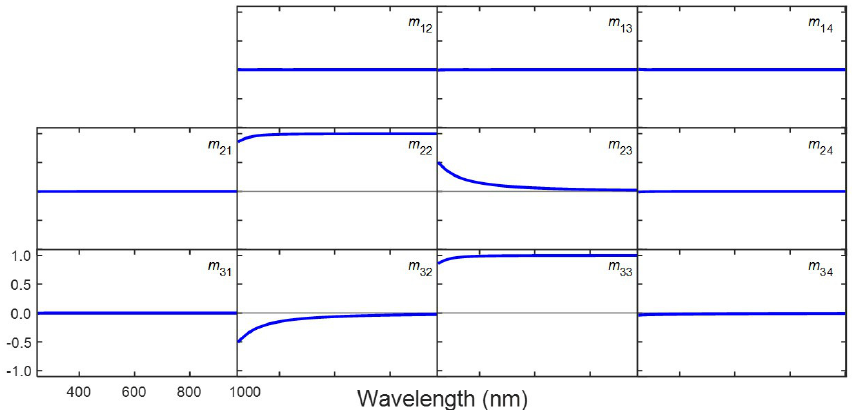
Figure 16. Partial Mueller matrix measured on a D-glucose solution using a rotating analyzer/fixed compensator spectroscopic